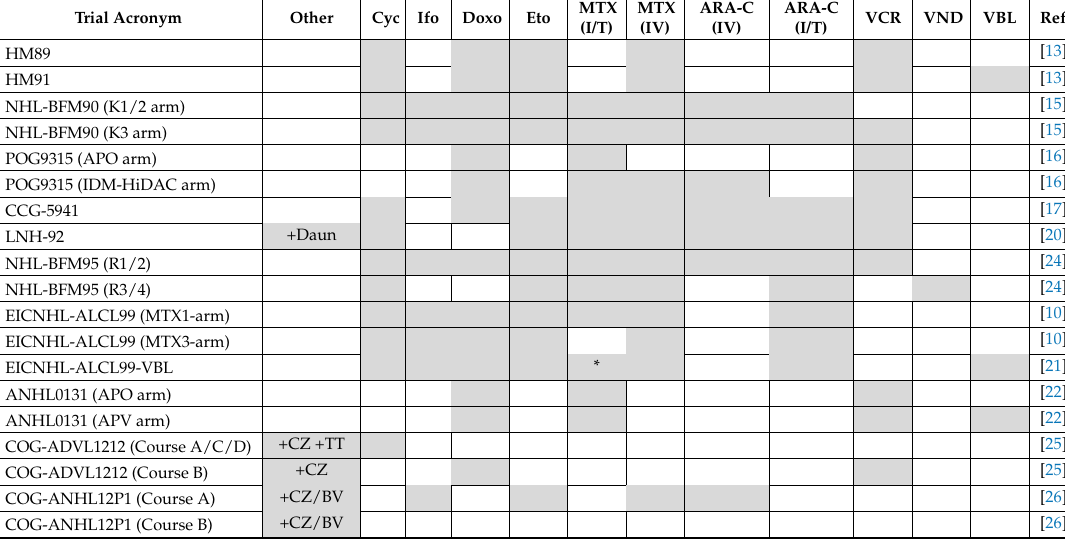
Vindesine. Not detailed in the table: prednisone, prednisolone, dexamethasone and food supplements. * Randomized into MTX1 or MTX3 arm. Shaded area indicates drugs used in the protocol. Trial